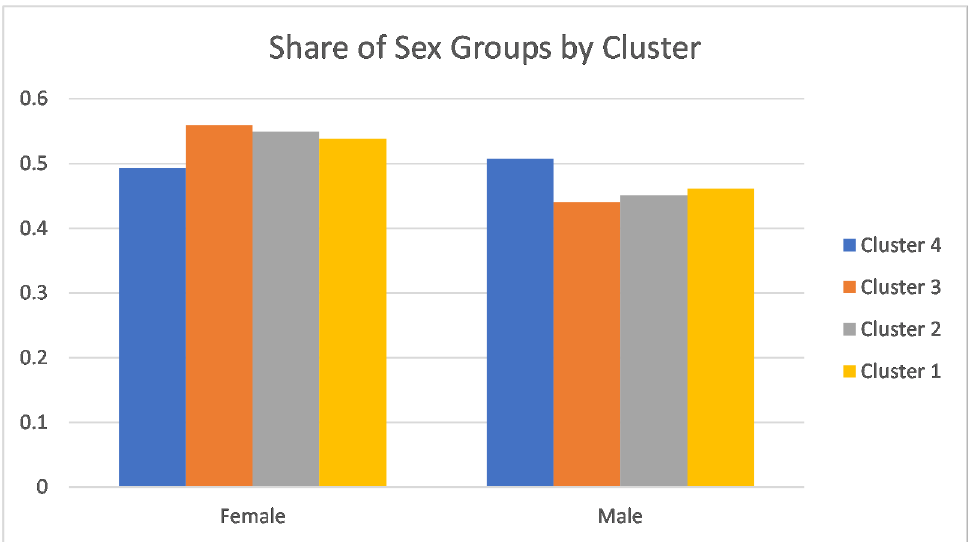
Figure 12. Proportion of individuals for each sex group allocated to clusters. Given as a percentage. Cluster 4 was the high-mortality cluster.